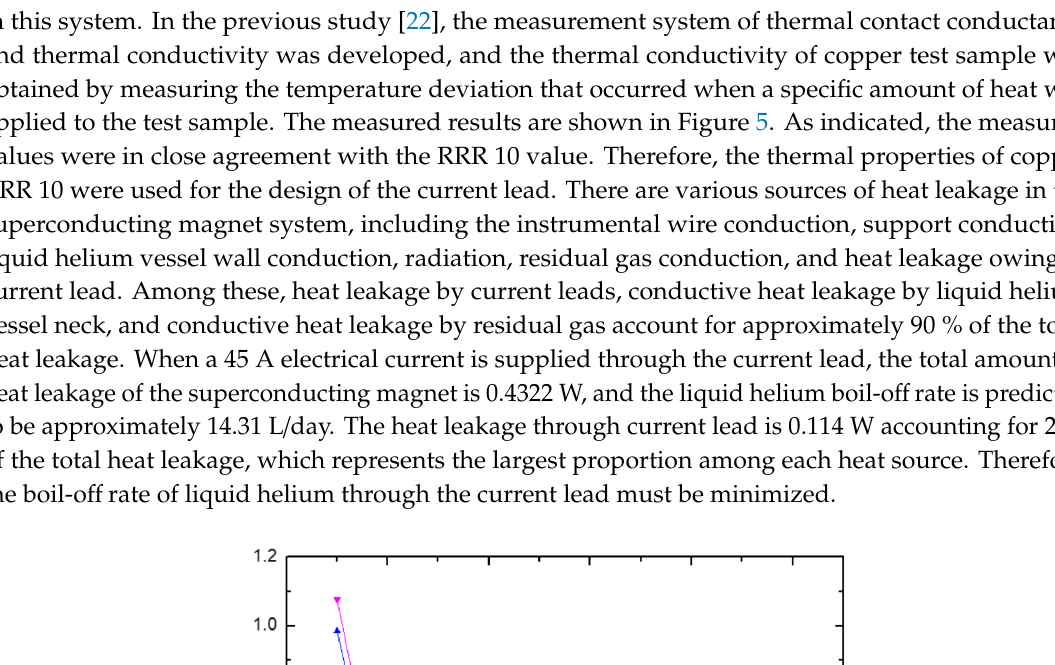
Figure 3. Thermal properties of metals as a function of temperature.